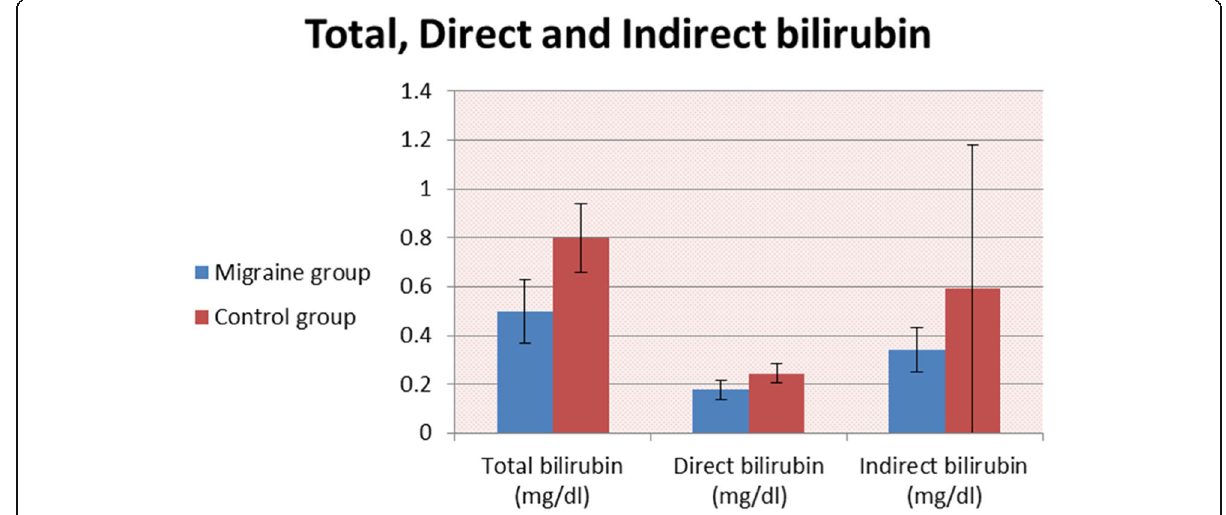
Fig. 1 Lower serum total, direct, and indirect bilirubin concentrations in the migraine group compared with the control group